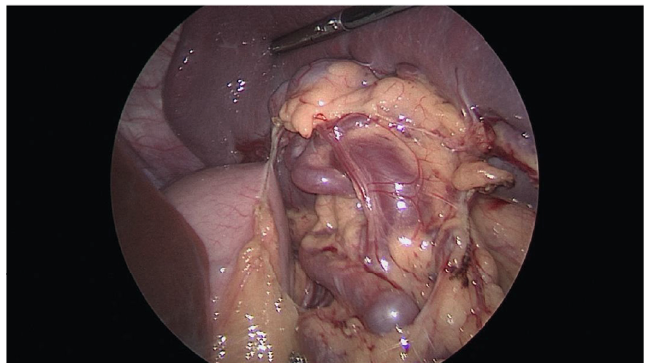
Figure 3: Intraoperative image of the splenic artery aneurysm (reproduced from Meghan et al. [9], [under the Creative Commons Attribution License/public